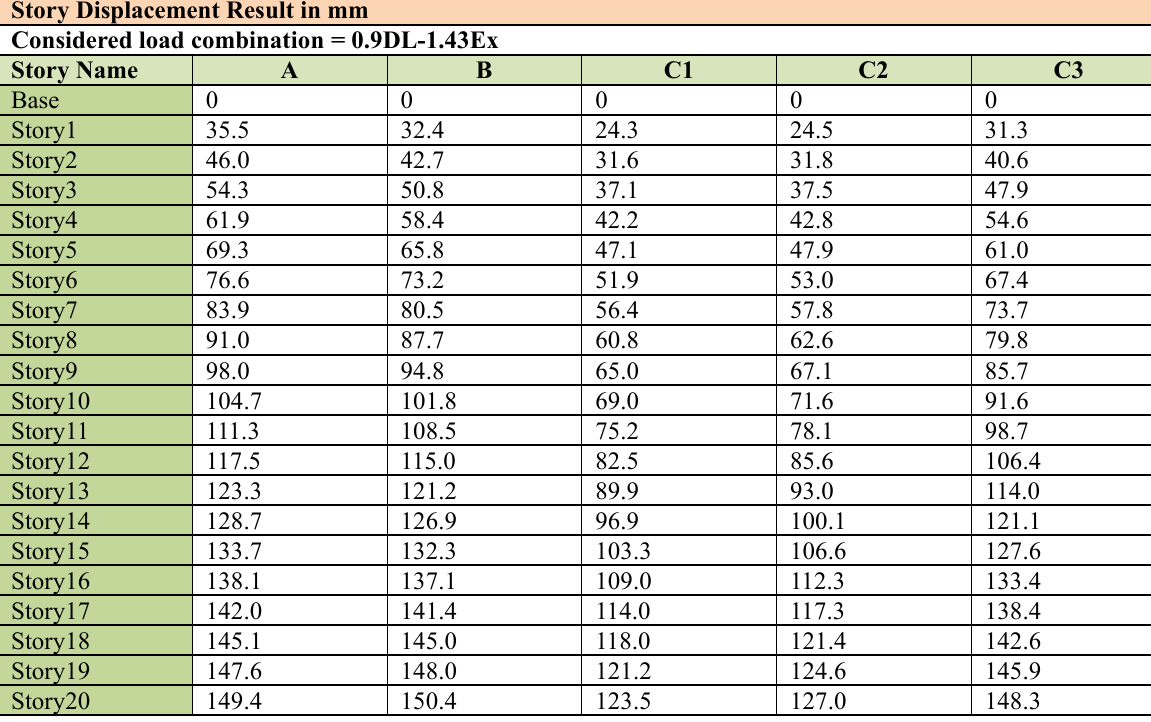
Story displacement from ETABS result (Analysis aproach 01). Story Displacement Result in mm